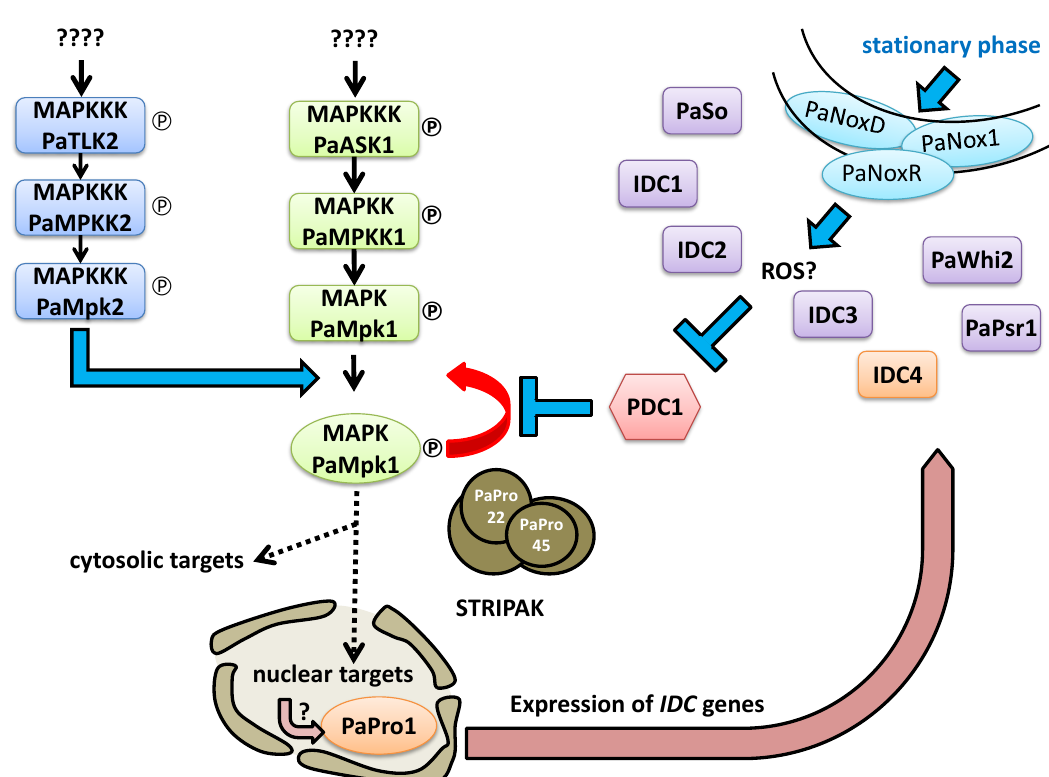
Figure 7. Scheme of the IDC signaling cascade. PDC1 encodes a repressor of the cascade, which was shown to likely repress the positive regulatory loop of the PaMpk1 MAPK cascade [45]. Double mutants of PDC1 and either PaMpk1 or PaMpk2 never present CG. On the contrary, double mutants lacking PDC1 and either one of the upstream IDC proteins may exhibit CG sectors during growth since the positive regulatory loop is not repressed, yet these are not induced by passage into stationary phase, because the signal between the PaNox1 complex and the MAPK is not